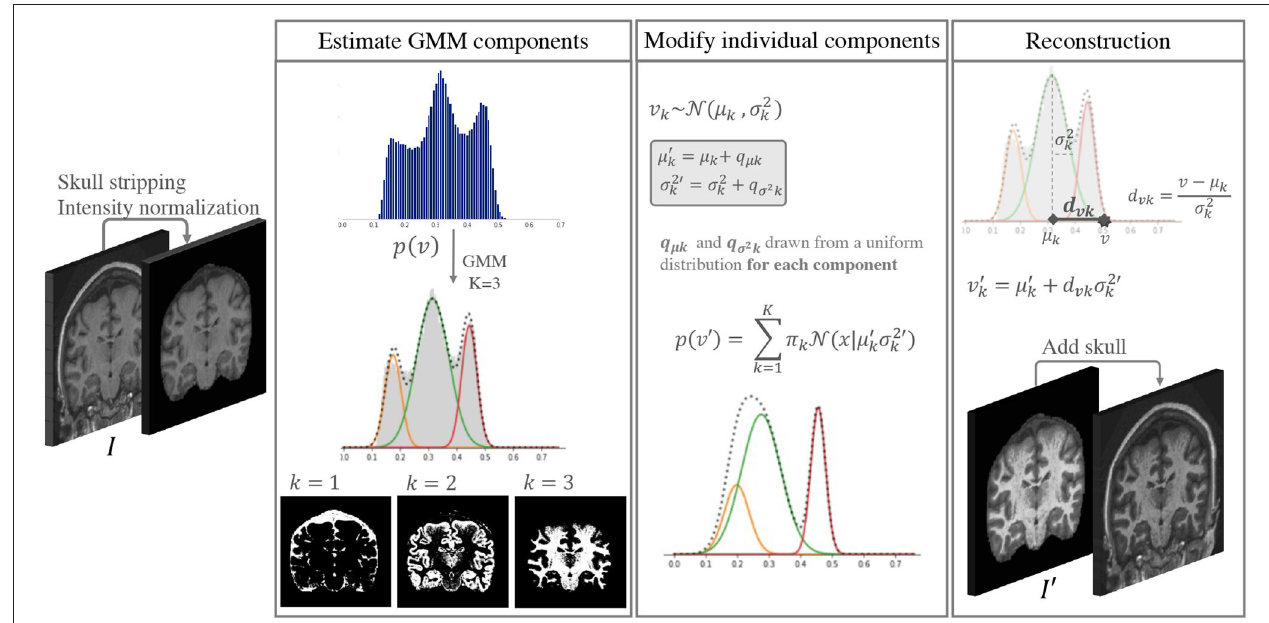
FIGURE 1 | Diagram of the main steps in the proposed DA method. This augmentation is performed only while training the segmentation